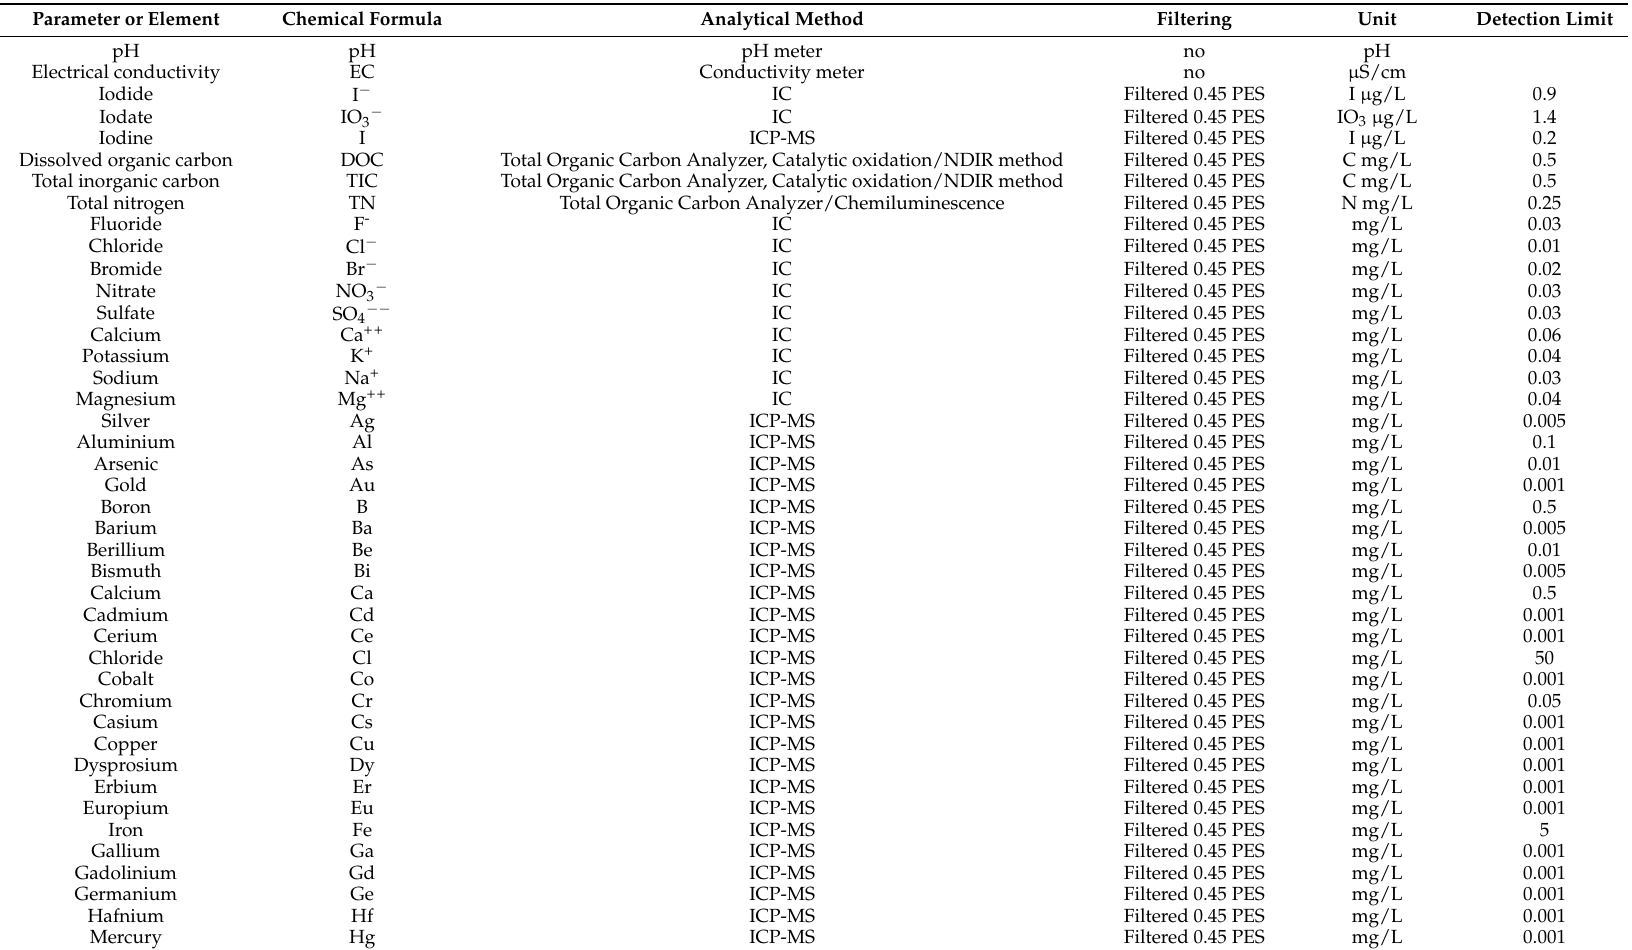
Table A2. Methodological details for all analyzed parameters and chemical